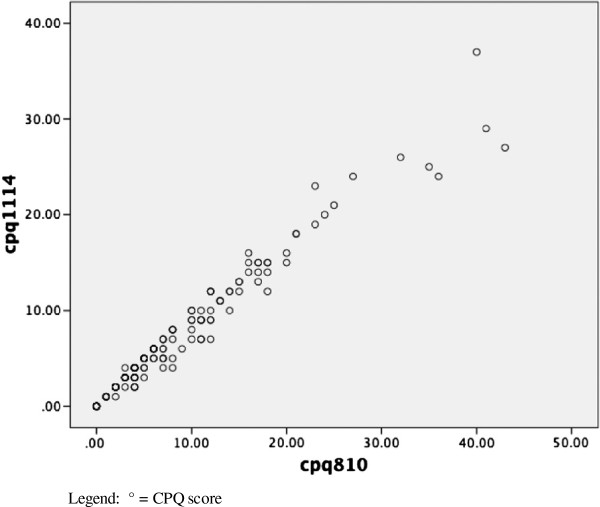
Scatterplot of scale scores of the CPQ11-14 and CPQ8-10. Legend: ° = CPQ score.